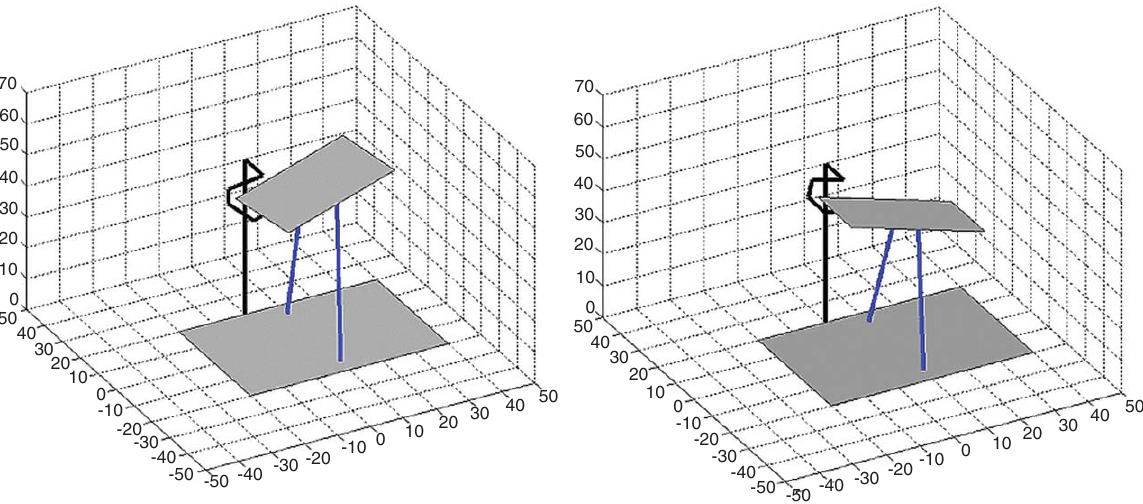
Fig. 10. The robotic platform in 2 different